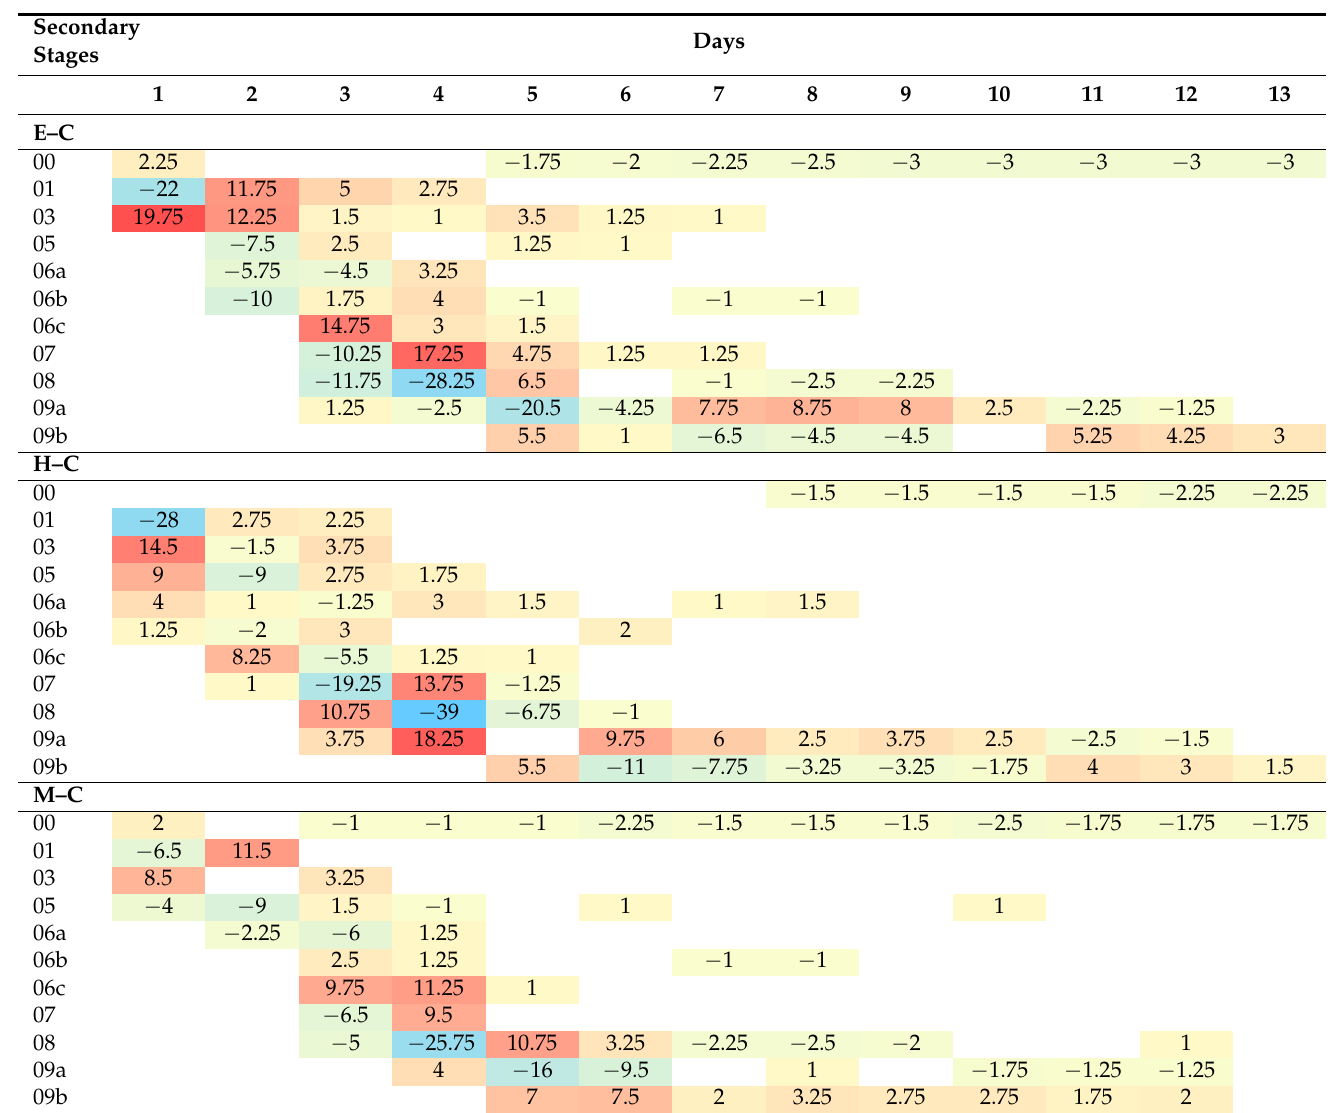
Table 3. The effect of seed priming methods on the pattern germination compared with control